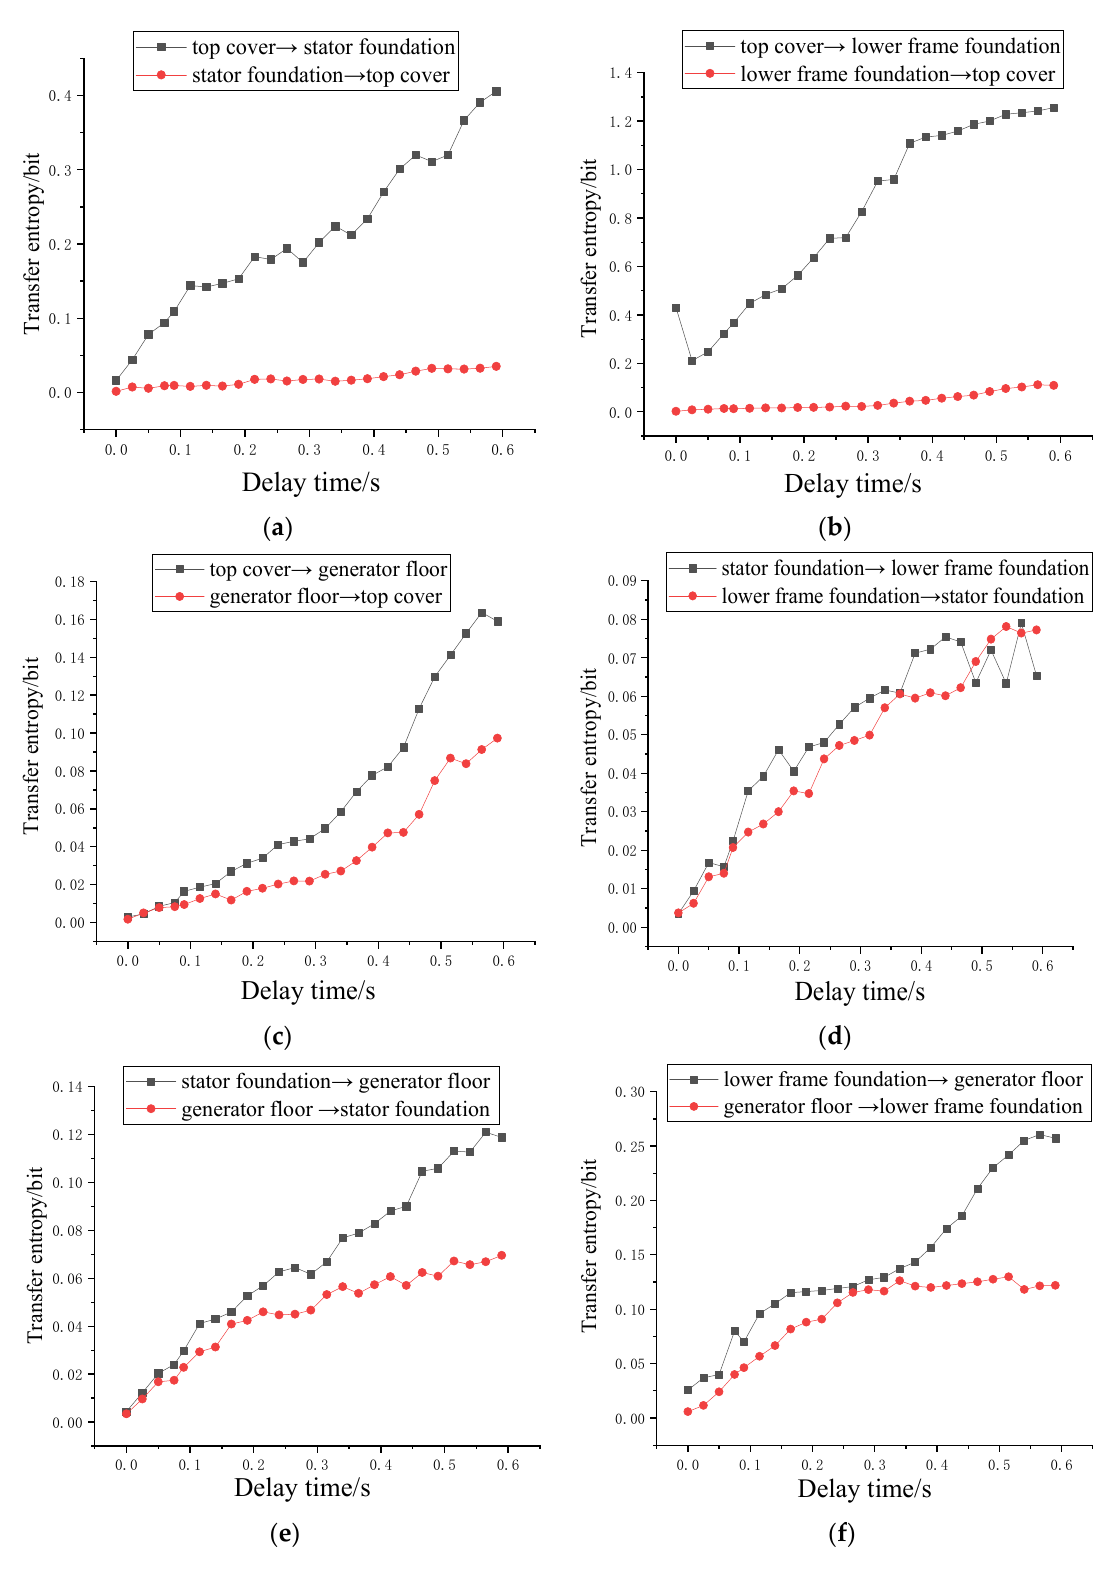
Figure 14. Transfer-entropy curve between measurement points of condition 1. ( a ) Transfer-entropy curve of top cover and stator foundation; ( b ) Transfer-entropy curve of top cover and lower frame foundation; ( c ) Transfer-entropy curve of top cover and generator floor; ( d ) Transfer-entropy curve of stator foundation and lower frame foundation; ( e ) Transfer-entropy curve of stator foundation and generator floor; ( f ) Transfer-entropy curve of lower frame foundation and generator floor. Table 4. Information-transmission rate between measurement points of condition 1.